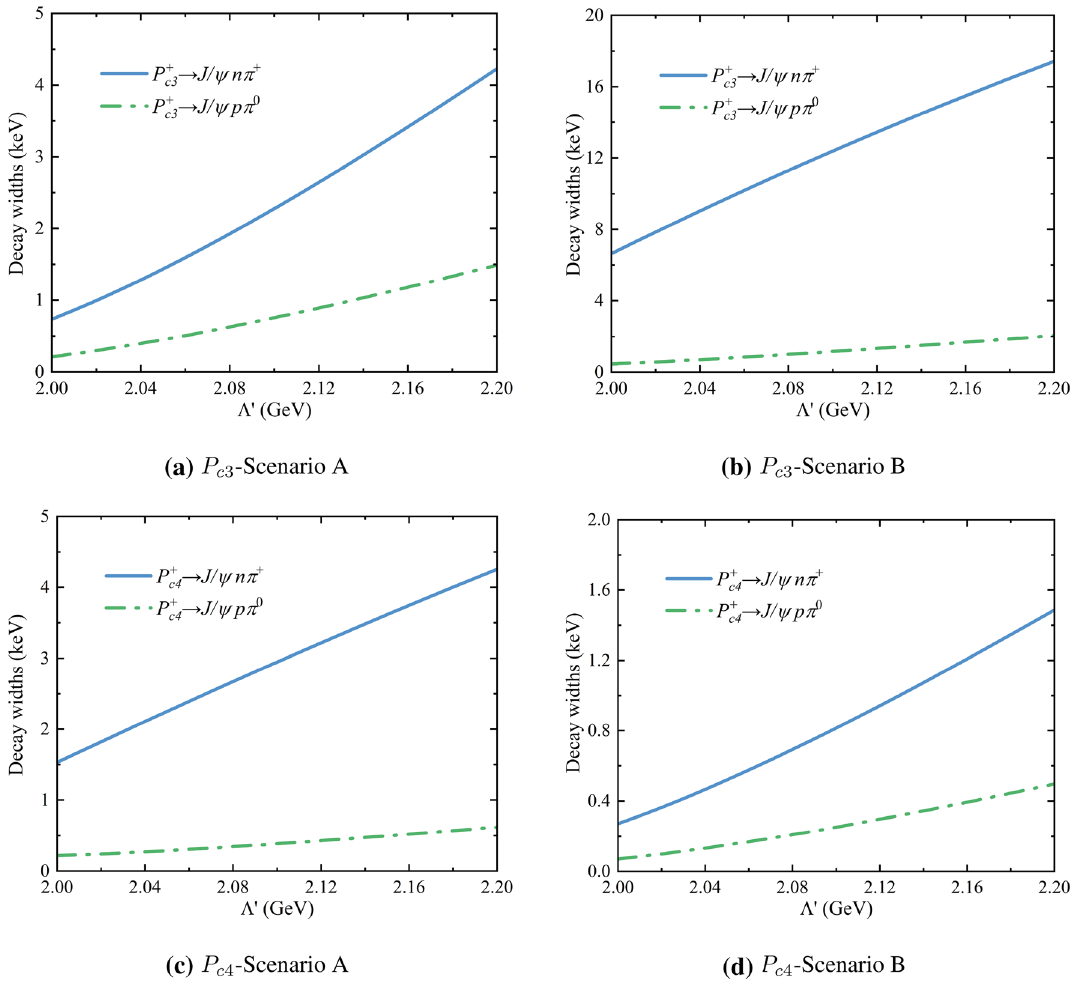
→ J /ψ n π + and P + → J /ψ p π 0 as a function of the cutoff (cid:4) (cid:9) in the form factors (A15). The results are Fig. 3 Partial decay widths of P + c 3 | c 4 c 3 | c 4 represented by the blue solid lines and green dot-dashed lines, respectively, which correspond to the couplings determined for a cutoff (cid:4) = 1 . 5